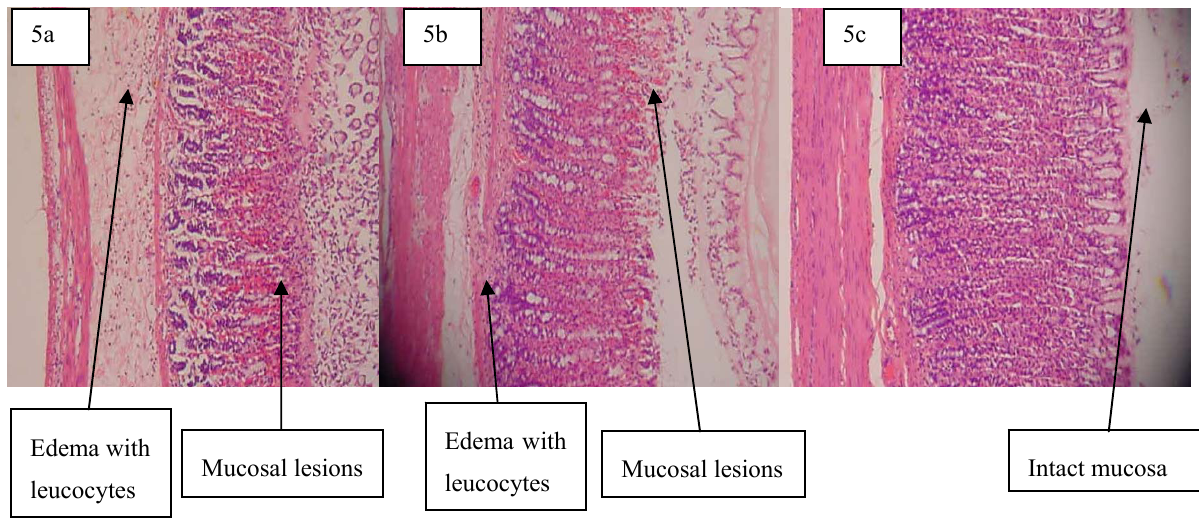
Figure 5. Histology and pathology snapshots of gastric mucosa ( 5a ) in a rat pre-treated with distilled water only. There is severe disruption to the surface epithelium, and edema of the submucosa layer with leucocyte infiltration, ( 5b ) in a rat pre-treated with omeprazole (20 mg/kg). There is mild disruption to the surface epithelium with mild edema and leucocyte infiltration of the submucosal layer, ( 5c ) in a rat pre-treated with 5 mg/kg of adiponectin. There is mild disruption to the surface epithelium with no edema and no leucocyte infiltration of the submucosal